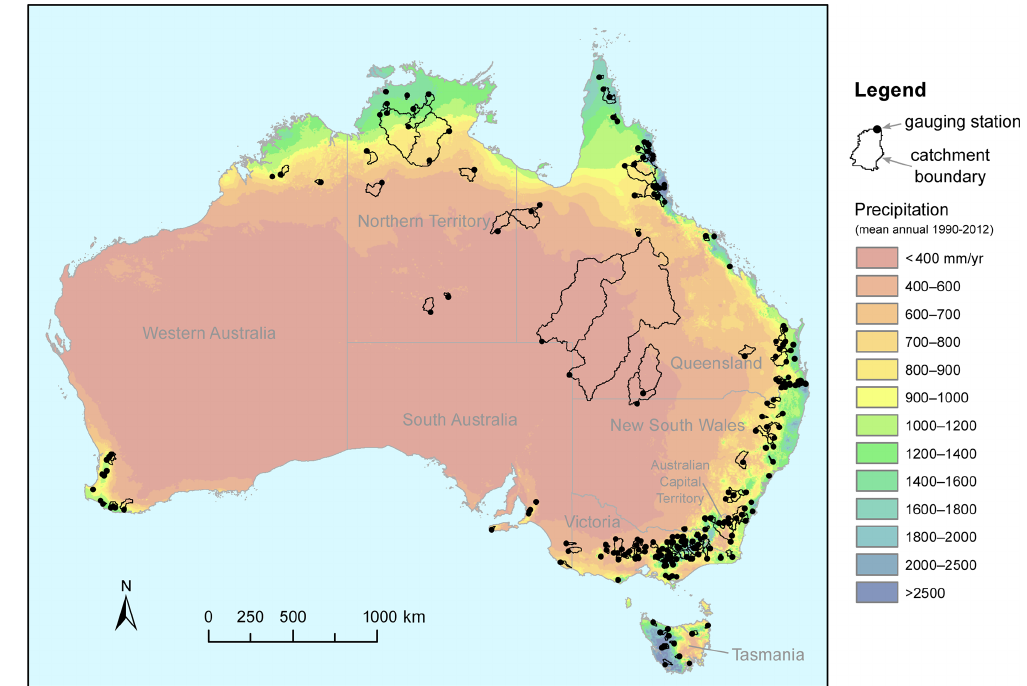
Figure 1. Location of the 222 CAMELS-AUS flow gauging stations and catchments, along with mean annual precipitation (from Jones et al., 2009) and Australian states and